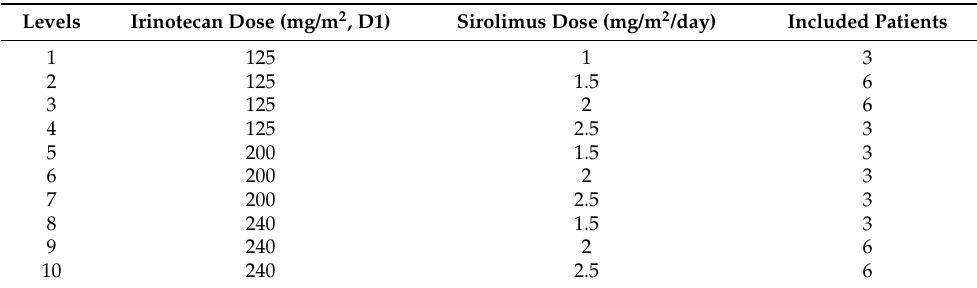
Table 1. RAPIRI phase I trial characteristic with the levels, doses of irinotecan and sirolimus, and the number of patients included in each